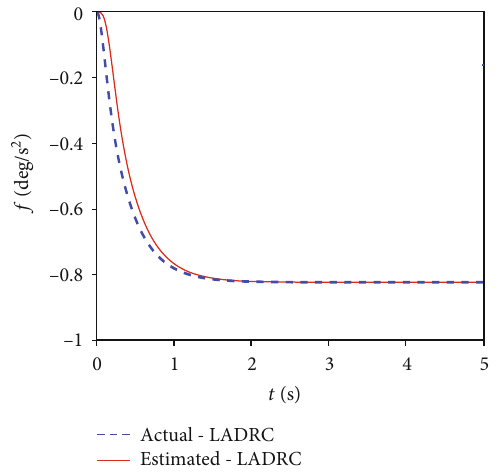
Figure 7: Estimation of f with